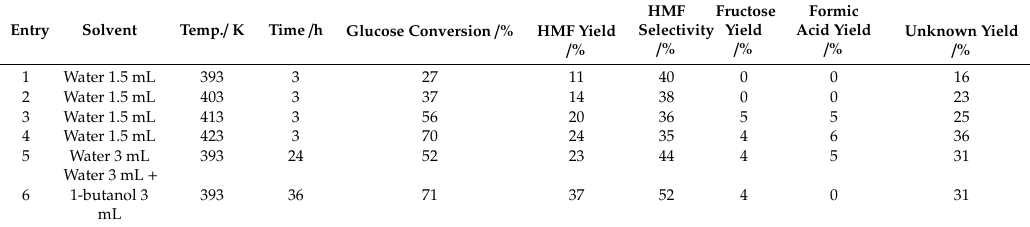
Table 4. Effects of reaction temperature and solvent on HMF formation from glucose over HNbWO 6 aggregated nanosheets a .